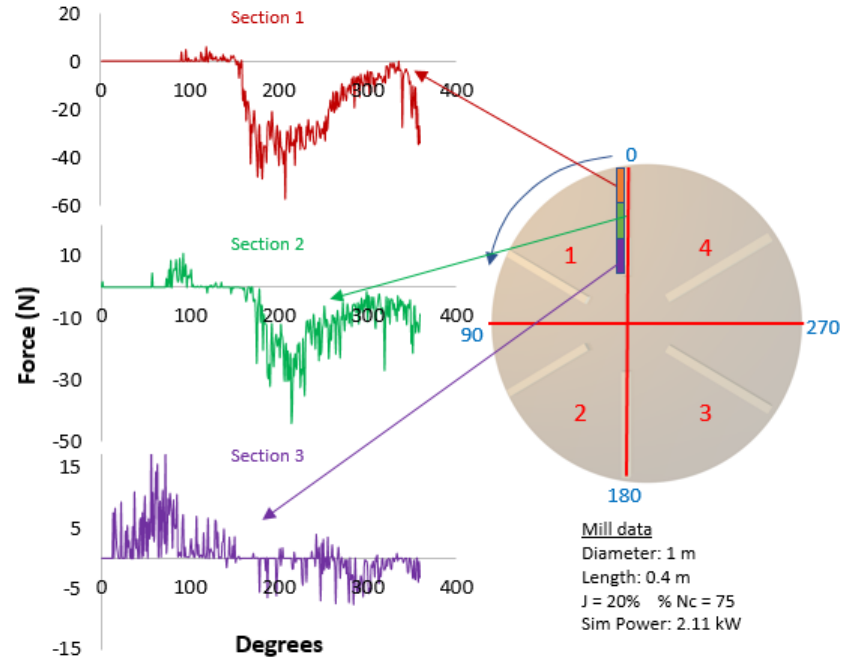
Figure 9. Sectional forces obtained by averaging the forces on all six end lifters (25 mm × 25 mm square liners, 25 mm ball size and 20% ball filling).